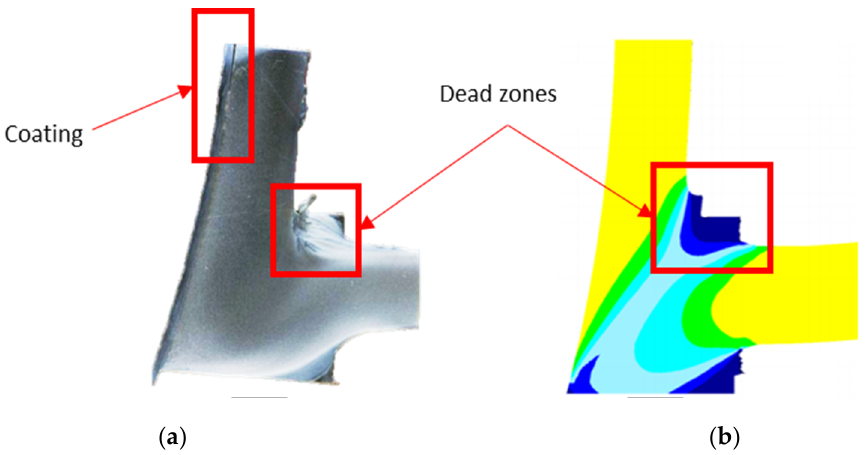
Figure 2. Comparison of ( a ) real workpiece flow and ( b ) numerical simulation in the forming chamber.